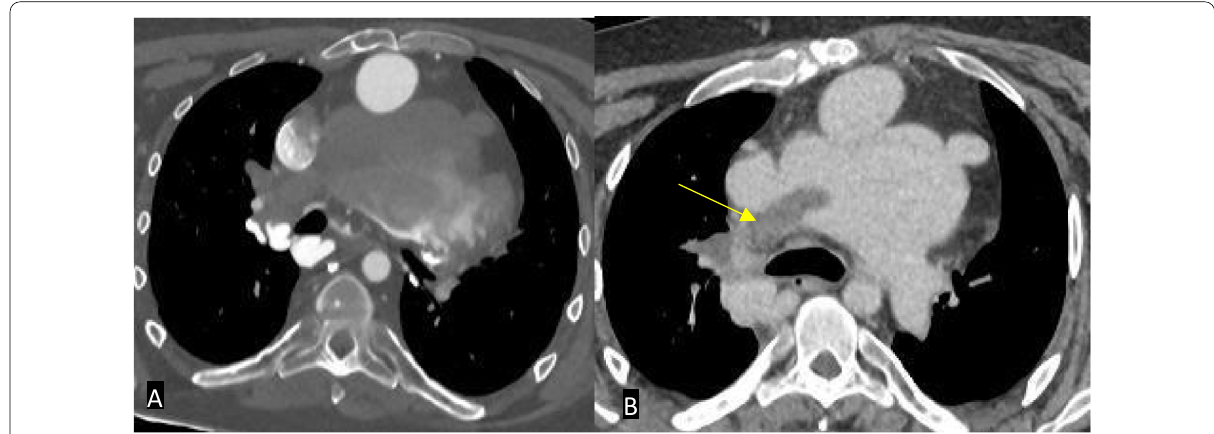
Fig. 9 Axial CT images in a patient with an extra-cardiac conduit Fontan circuit. A Inadequate protocolling which resulted in suboptimal opacification of the circuit. Note that it is impossible to identify a true thrombus. B A single contrast phase, delayed phase acquisition protocol was subsequently used in the same patient which opacified the Fontan circuit adequately and allowed identification of a thrombus in the right main pulmonary artery (yellow